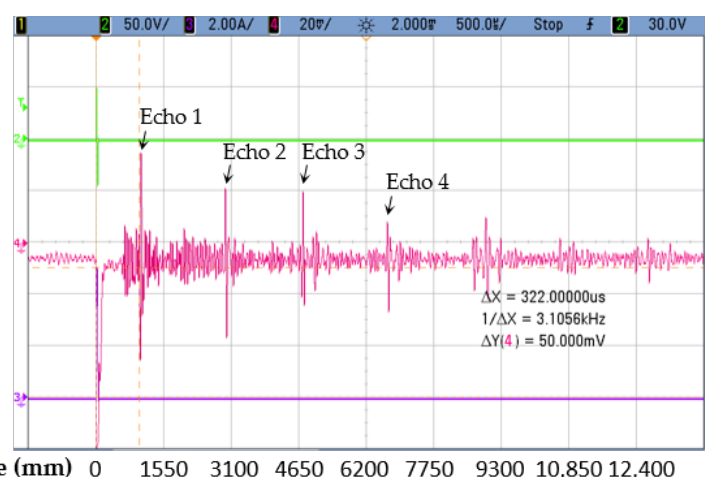
Figure 18. Received echoes using full-bridge+buck converter.